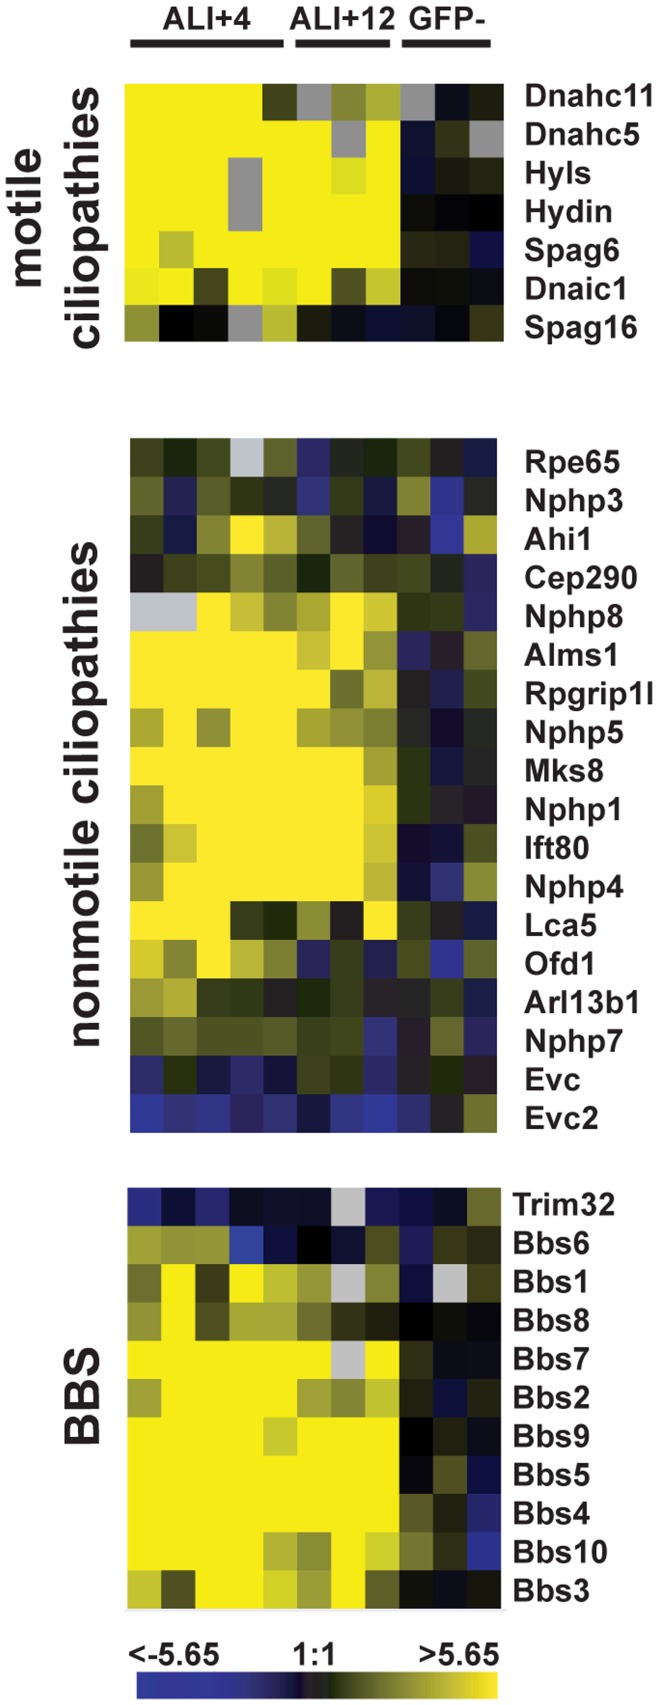
Differential regulation of disease genes associated with motile and nonmotile ciliopathies.Heat maps showing the expression of genes associated with motile (top) and nonmotile (middle) ciliopathies, as well as genes linked to Bardet-Biedl syndrome (bottom), a model ciliopathy.